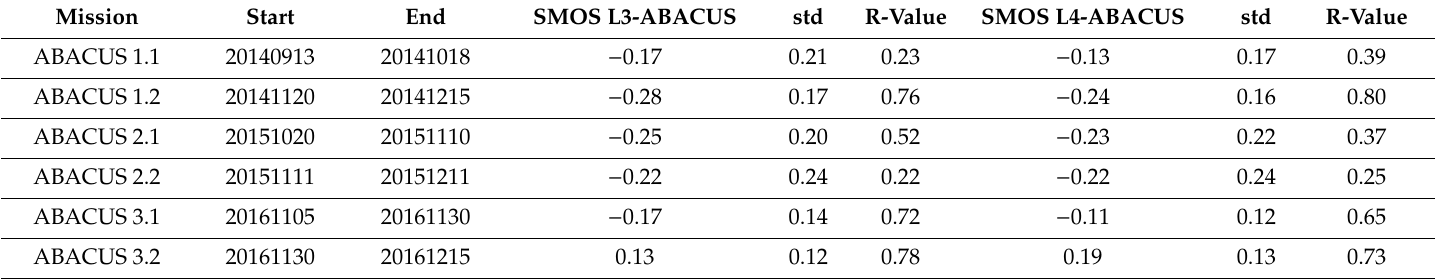
Table 2. Main statistics (mean; standard deviation; linear correlation) of daily di ff erences computed between BEC SMOS L3 / L4 SSS and ABACUS in situ SSS along the analyzed glider